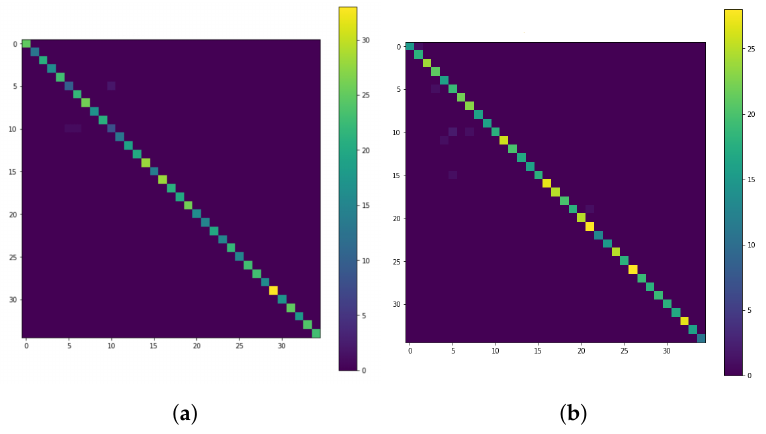
Figure 2. Confusion matrices for the RSI-CB256 dataset: ( a ) validation. ( b )